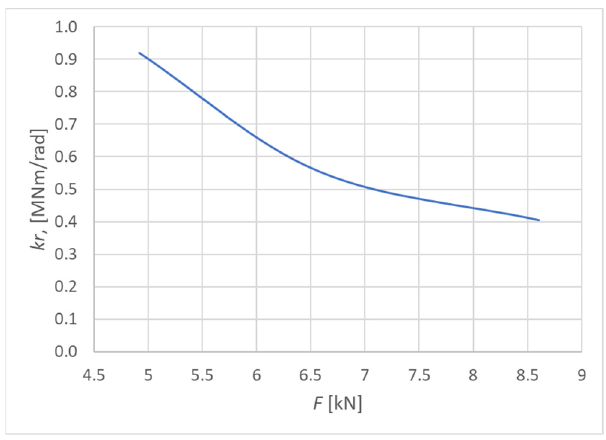
Figure 18. Trend of rotational stiffness for Experiment